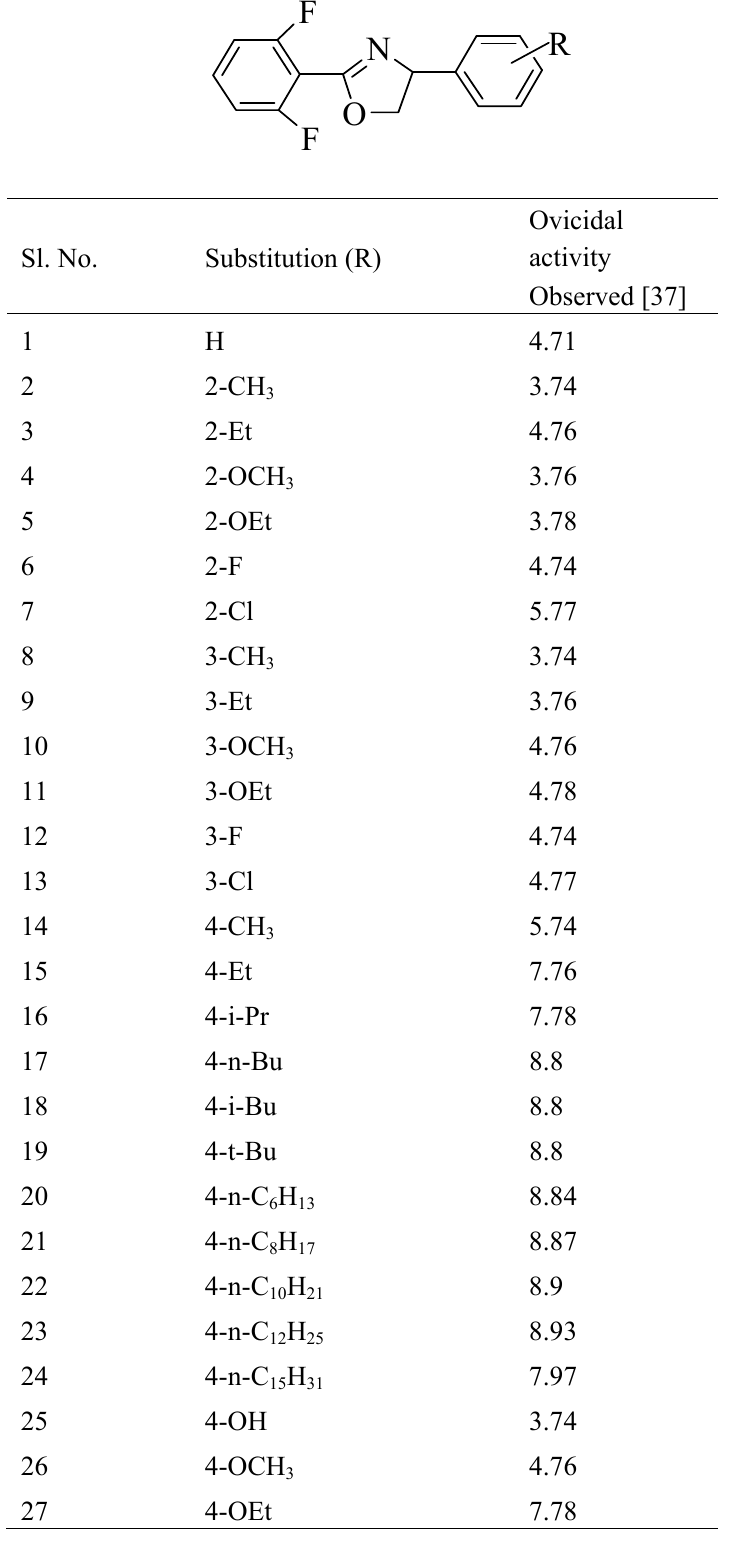
Table 2. Structural features and ovicidal activity of 2-(2 ′ ,6 ′ -difluorophenyl)-4-phenyl-1,3- oxazoline